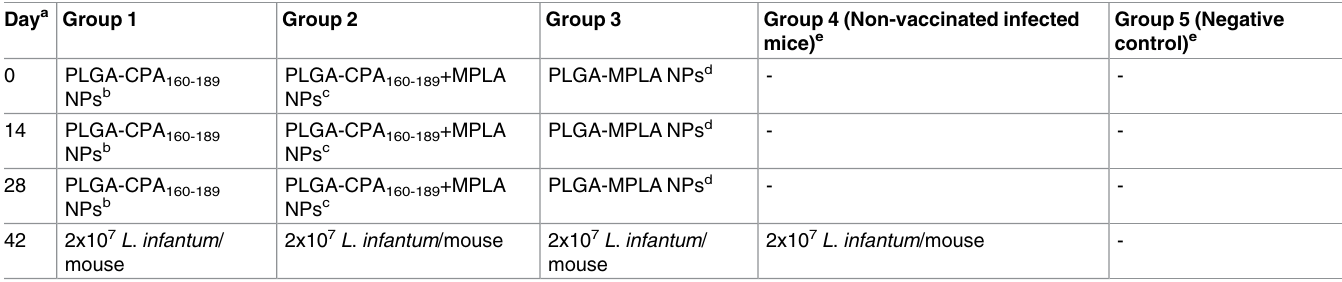
Table 1. Vaccination and challenge schedule in BALB/c